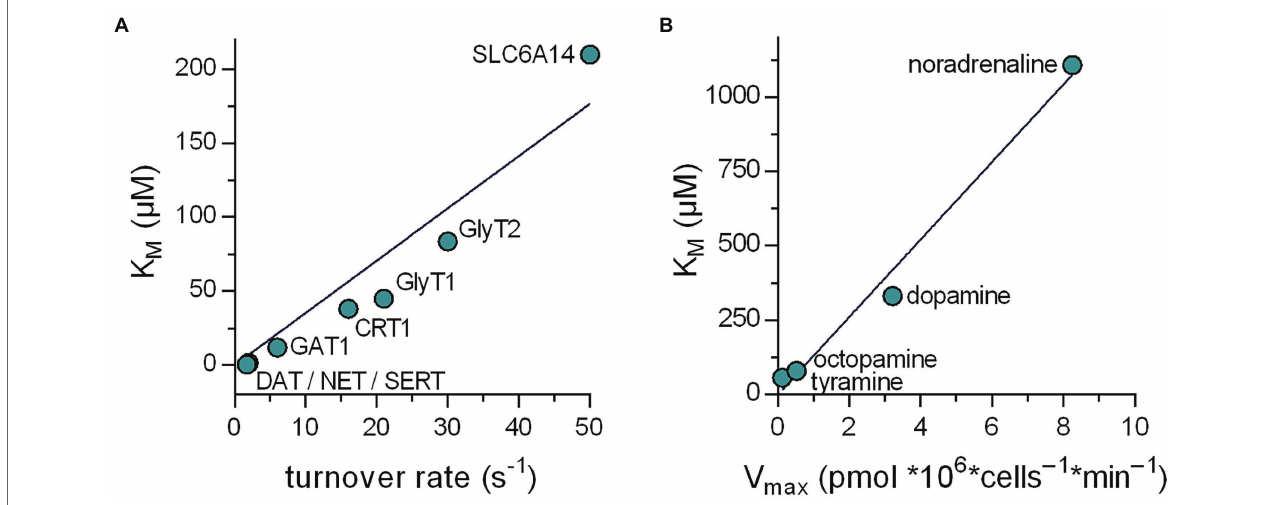
FIGURE 6 | Relation between the K M and the substrate turnover rate of transporters in the SLC6 family. (A) Plotted are data obtained from literature of eight members of the SLC6 family. The line in the graph is a linear fit to the data points ( r 2 = .915). It is evident that in the real world a positive correlation exists between the K M and the turnover rate. (B) Relation between K M and V max for the various substrates of the Lumbricus terrestris monoamine transporter. The data were taken from Caveney et al. (2006). The line in the graph is a linear fit to the data points ( r 2 =